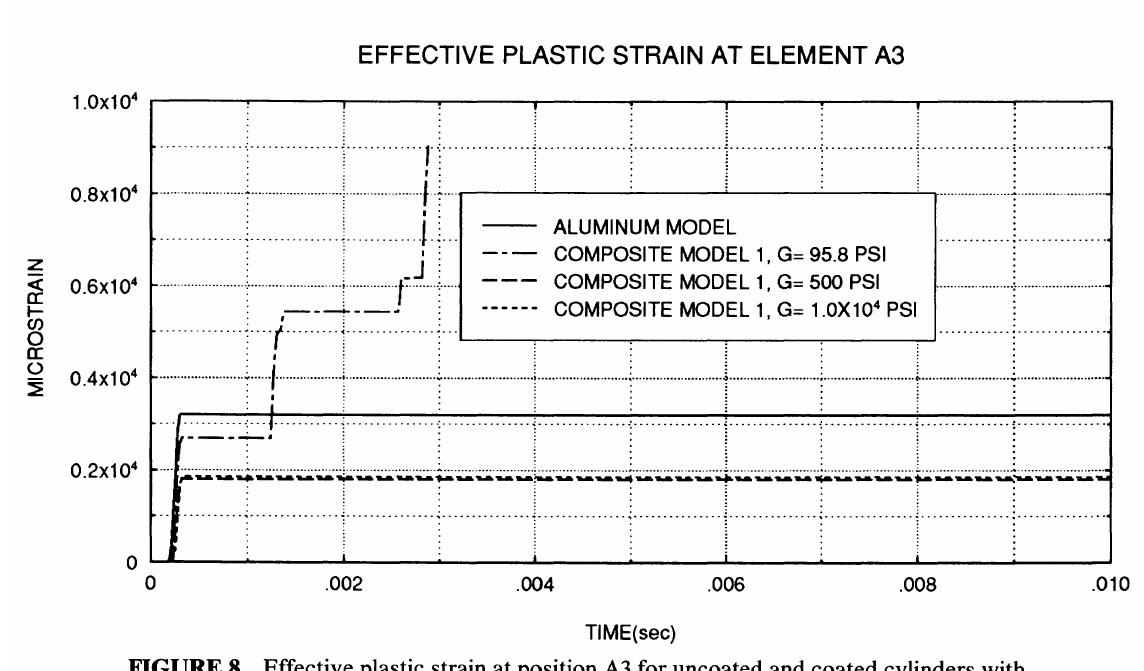
FIGURE 8 Effective plastic strain at position A3 for uncoated and coated cylinders with large variation of rubber shear